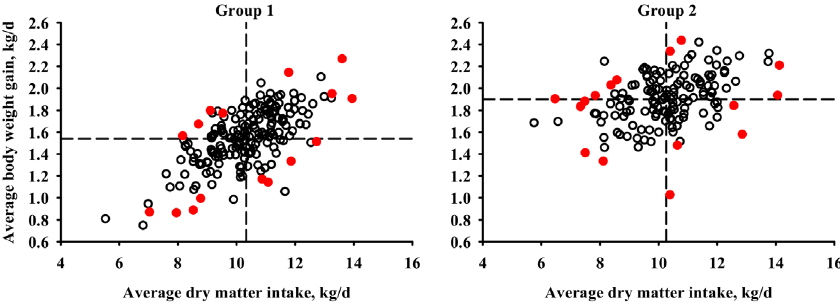
Fig 1. Feed Efficiency Sampling Model. A 2x2 factorial design consisting of high and low average daily feed intake (ADFI), and high and low average daily BW gain (ADG). Within a contemporary group, ADG was regressed on ADFI. Steers within each Cartesian quadrant were sampled, as represented by red dots (n = 16/group). Contemporary group 1(n = 197) ADFI was 10.33 ± 0.09 kg/d, and ADG was 1.54 ± 0.02 kg/d. Contemporary group 2 (n = 148) ADFI was 10.26 ± 0.12 kg/d, ADG was 1.90 ± 0.02